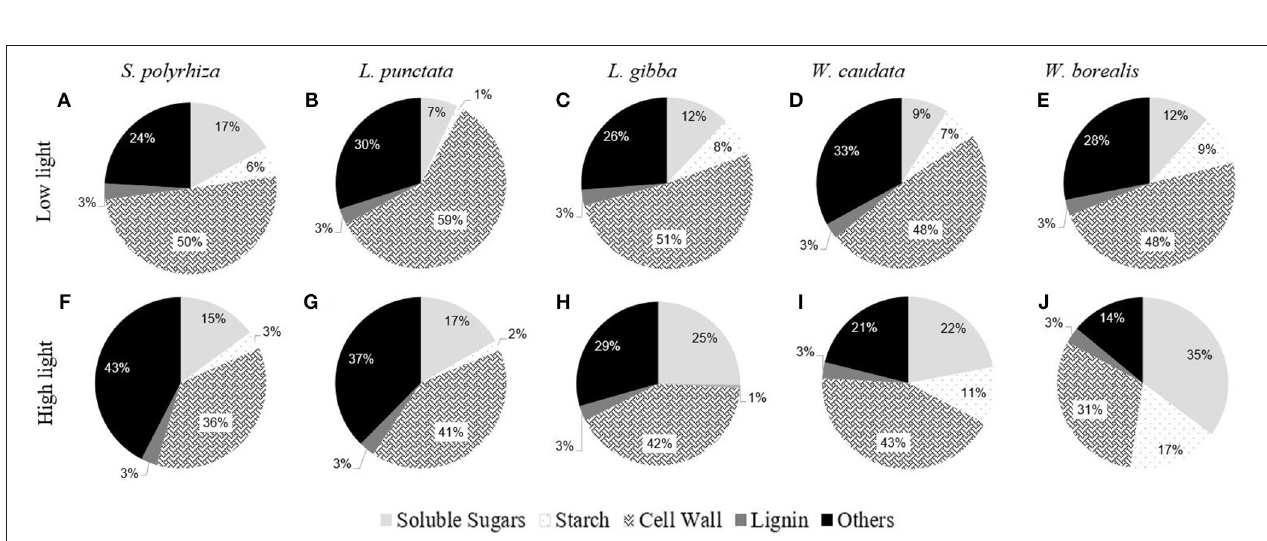
FIGURE 3 | Comparative composition of duckweeds ( S. polyrhiza, L. punctata, L. gibba, W. caudata , and W. borealis ) biomass cultivated under low light (20 µ mol.m − 2 .s − 1 ) and high light (500 µ mol.m − 2 .s − 1 ) intensity. Values are averages from the percentages of dry mass. Soluble sugars are the sum of the contents of sucrose, fructose, raffinose, and glucose. Cell walls are the residual portion of de-starched AIR. ( n = 4). The capital letters represent the species and the light treatment. (A–E) are the biomass composition of plants cultivated under low light and (F–J) under high light.